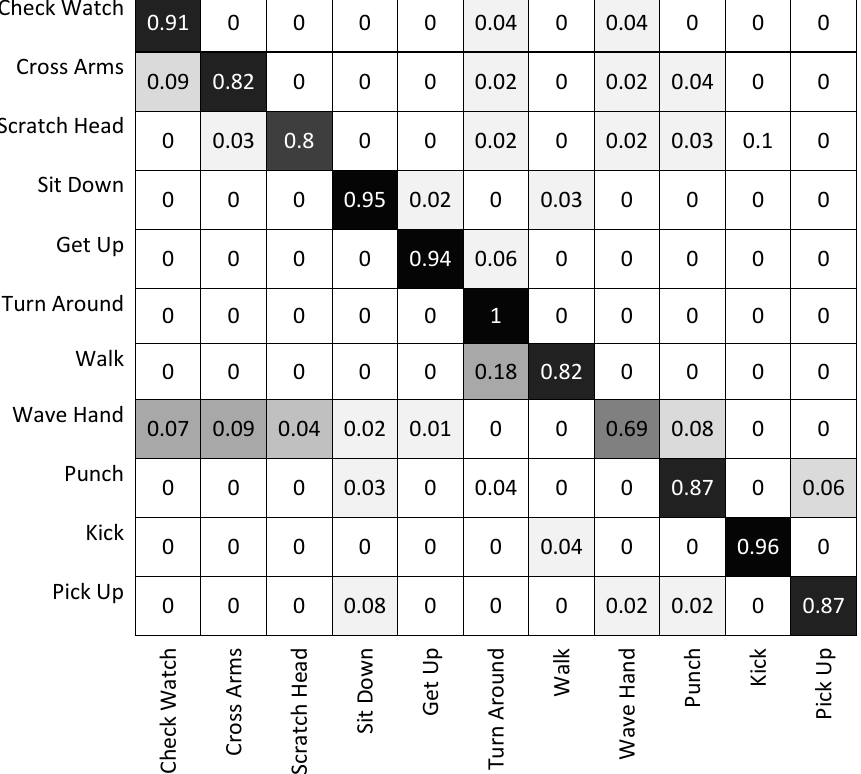
Figure 7. The confusion matrix of the recognition output on the IXMAS